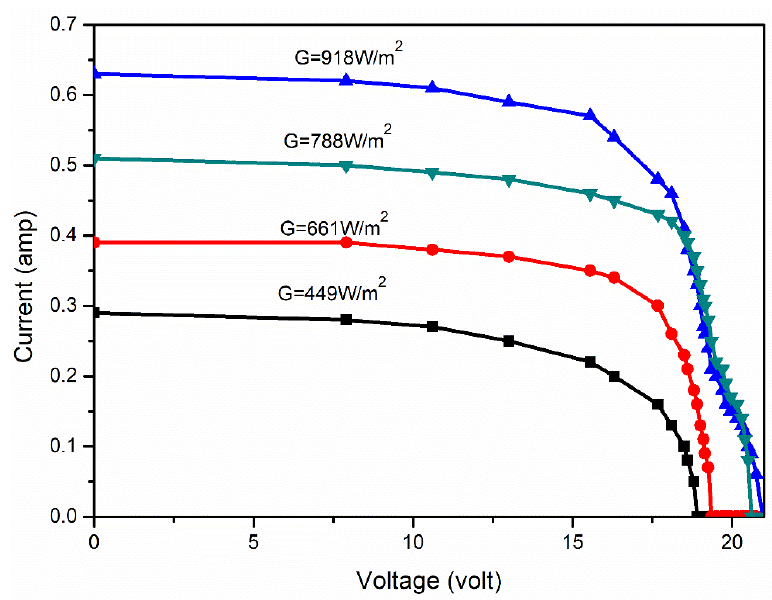
Figure 6. I-V curves of the solar PV panel for different solar irradiance.